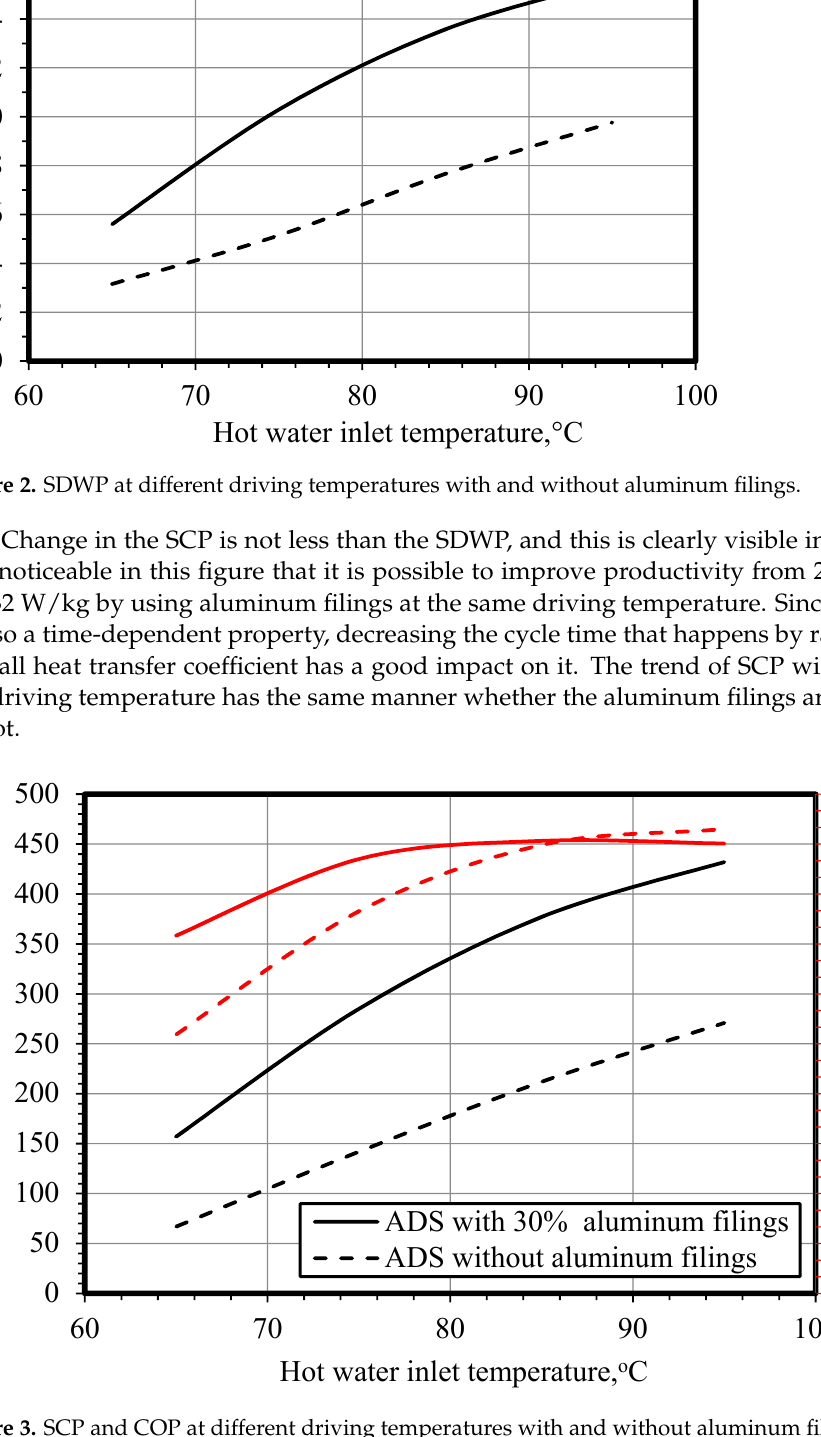
Figure 3. SCP and COP at different driving temperatures with and without aluminum filings.